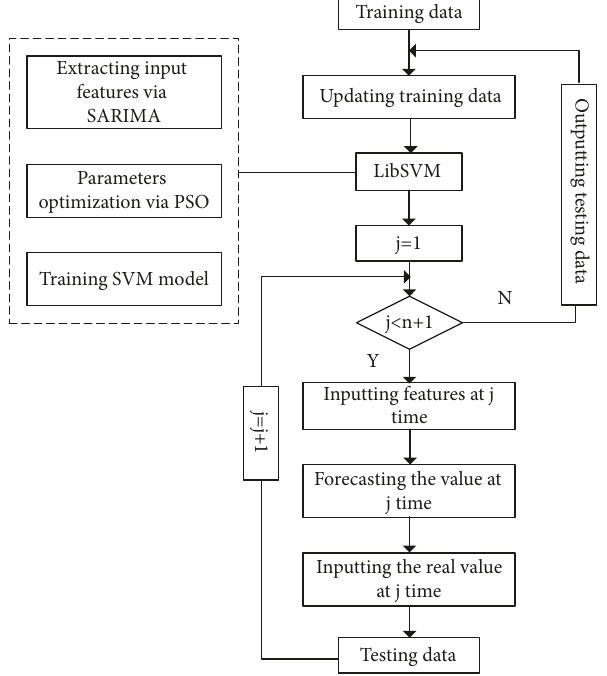
Figure 1: The process of constructing SVMOOL